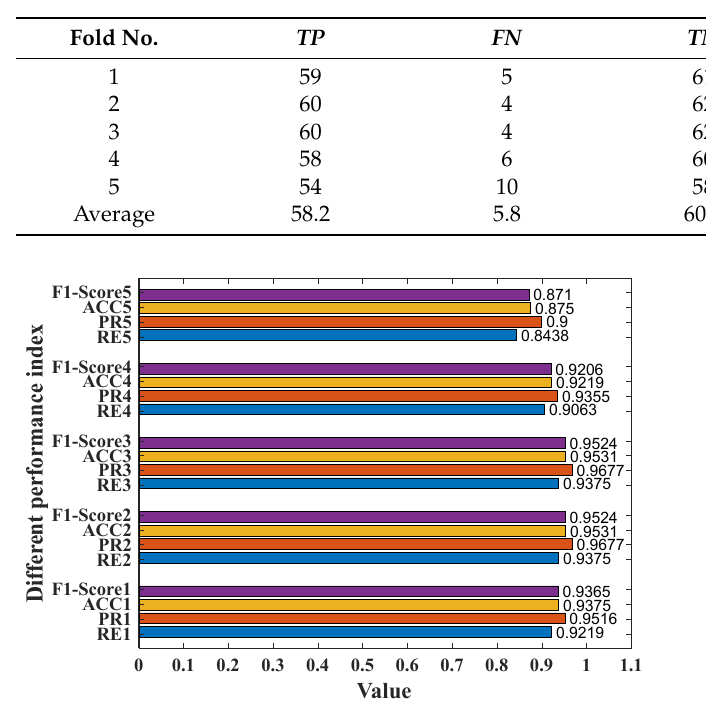
Figure 15. Different performance indices of 5-fold cross validation.